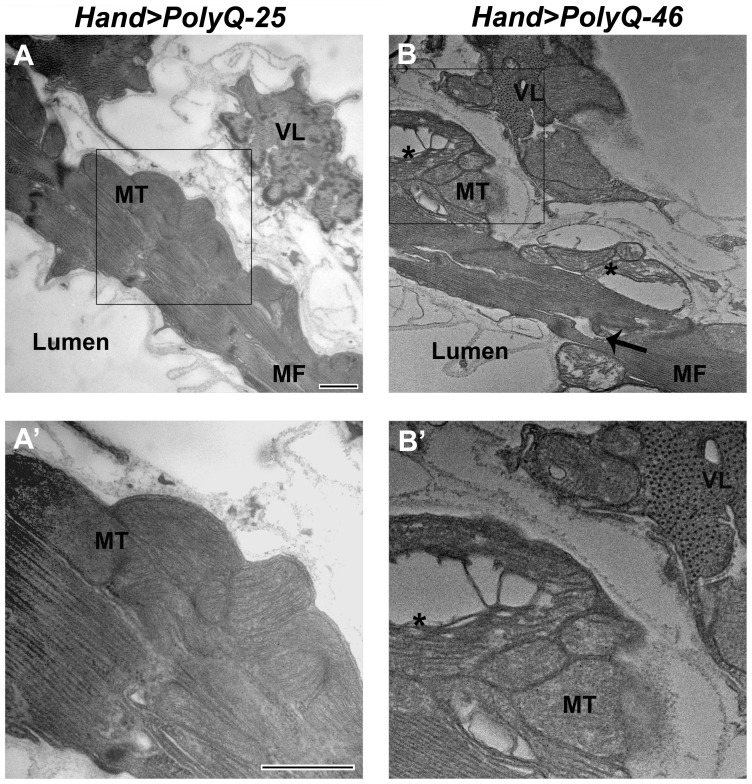
Mutant PolyQ causes myofibrillar and mitochondrial ultrastructural defects in the fly heart.(A, A') Electron micrograph of a cross section through the dorsal vessel of 4-week old PolyQ-25 controls reveals a layer of contractile myocardial cells which form the heart tube and a non-contractile supporting layer of ventral-longitudinal fibers (VL). Note that myofibrils (MF) are intact and mitochondria (MT) contain densely packed cristae. (B, B') In contrast, the myocardial layer of 4-week old PolyQ-46 hearts contains gaps indicating some myofibrillar degeneration (arrow) and severely fragmented mitochondria (asterisks). Bars, 500 nm.